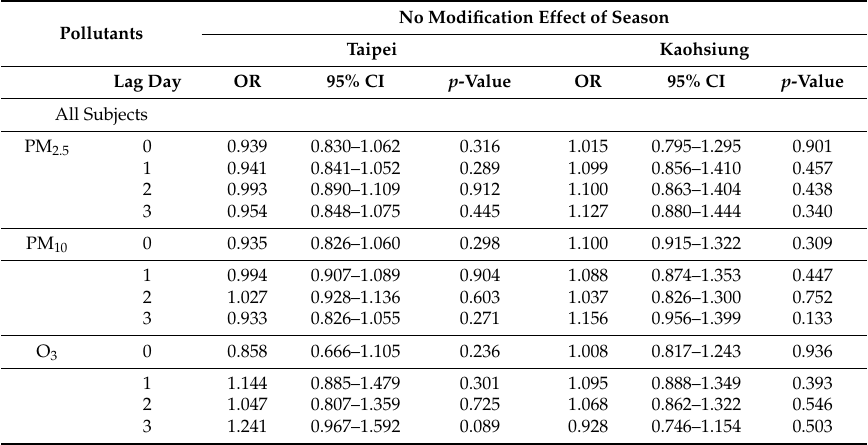
Table 3. Association between air pollution and childhood